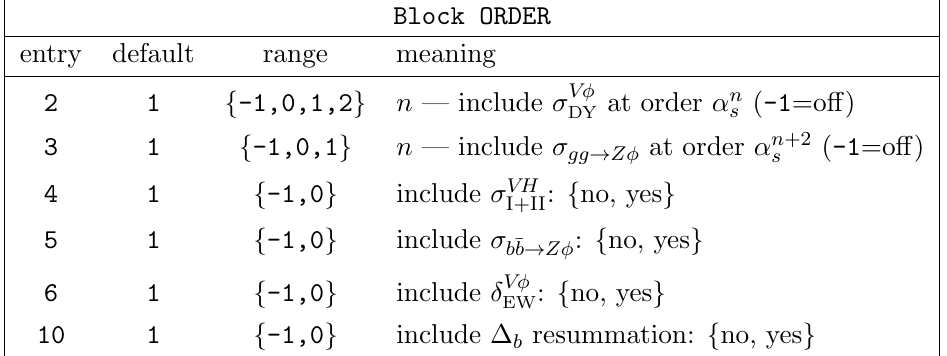
Table 3 . Controlling the sub-contributions de(cid:12)ned in eq. (2.1).